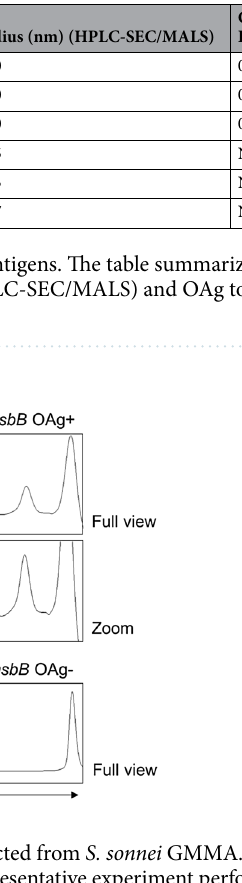
(Table 2). For the OAg-negative GMMA, the absence of OAg repeats was confirmed by High-Performance Anion- Exchange Chromatography coupled with Pulsed Electrochemical Detection (HPAEC-PAD) analysis, with lack of the characteristic sugars of the OAg repeating unit. Also, HPLC-SEC analysis on extracted sugars showed absence of G4C and MMW OAg and only presence of core molecules at 1.8 kDa (Fig. 1). Proteomic analysis of S. sonnei GMMA.